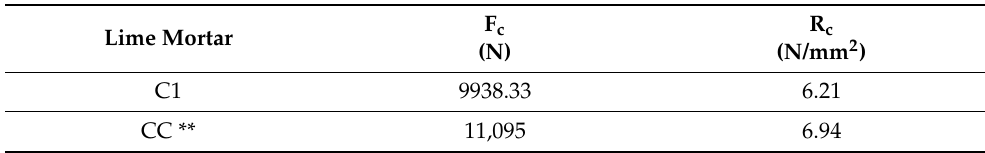
Table 11. Compressive strength test: lime mortar specimens treated with MYXOSTONE M3P. (mean